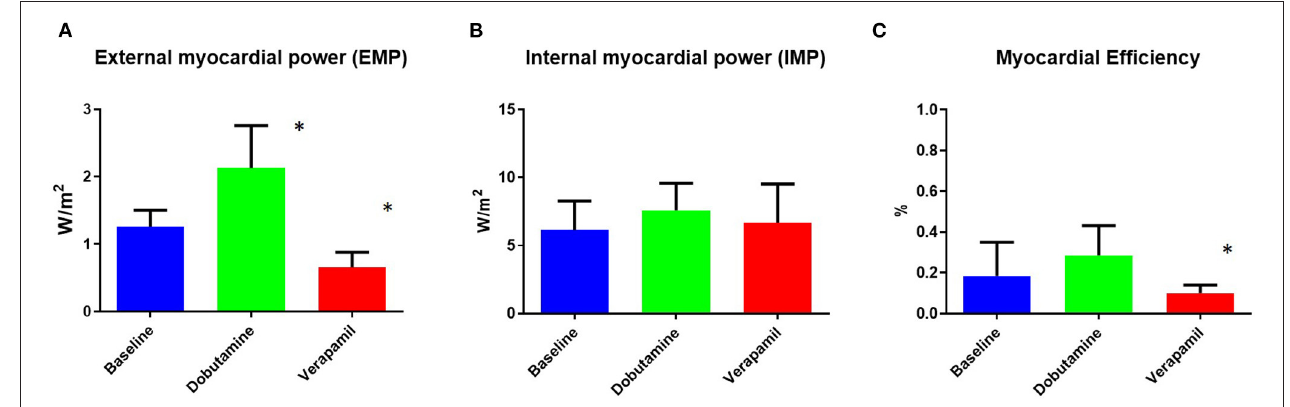
FIGURE 2 | Non-invasively measured myocardial power and efficiency at baseline and at dobutamine and verapamil states. Body surface area (BSA)-indexed external myocardial power (A) was found to be significantly different during both dobutamine-induced stress and verapamil-induced ischemia. No difference between states was found for BSA-indexed internal myocardial power (B) . Myocardial efficiency (C) was found to be significantly different only during verapamil-induced ischemia. EMP, external myocardial power; IMP, internal myocardial power. * p < 0.05 vs.